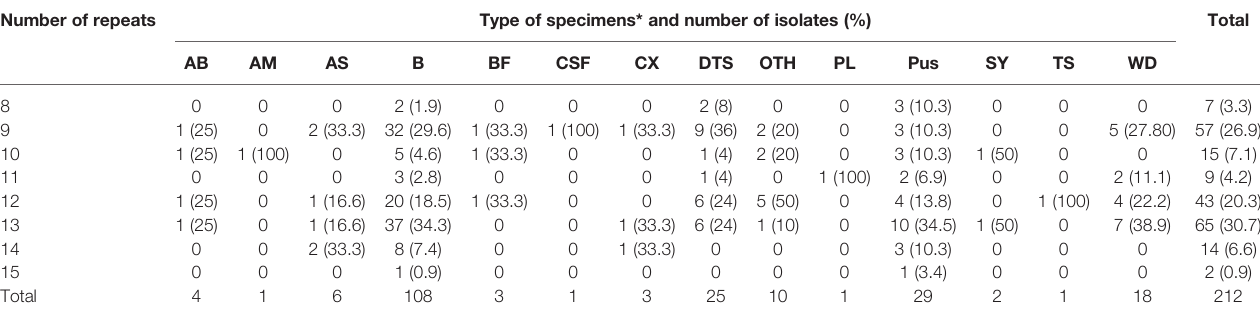
TABLE 1B | Repeat number distribution among different infection types. Infection Type